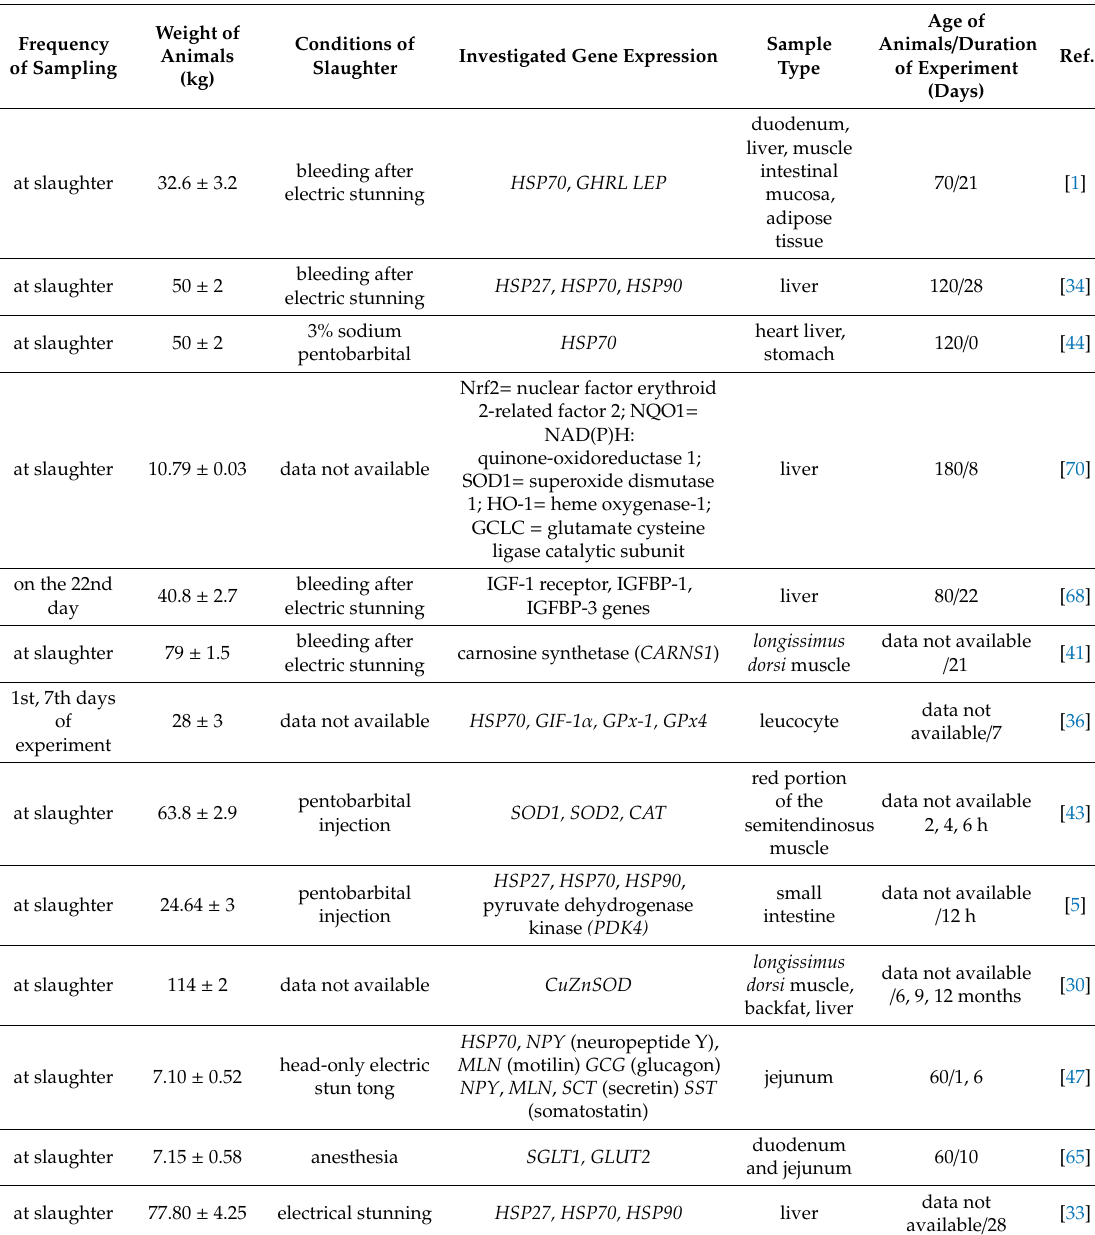
Table 2. Sampling conditions for the investigation of HS-related gene expression in